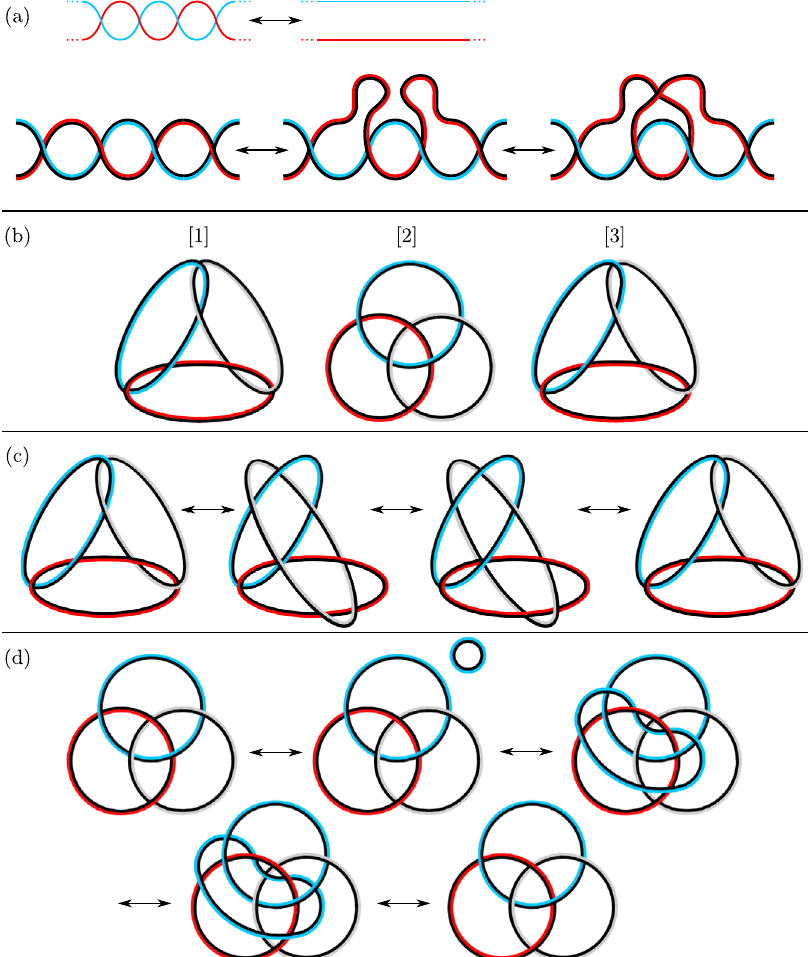
Fig. 13 The classi fi cation of Q 8 -colored links. a A surgery operation that can be employed to alter the linking number between two loops by an integer multiple of two. b The nontrivial classes of Q 8 -colored links, and the values of the invariant Q they correspond to. c In a looped chain con fi guration, it is possible to fl ip two of the three bicolorings by letting one of the loops go around the other two. d In a Borromean rings con fi guration, it is possible to fl ip any single bicoloring. In the picture, the blue loop is split into two loops, one of which goes around the red loop, resulting in the fl ipping of the red bicoloring. The two blue loops cross each other during this